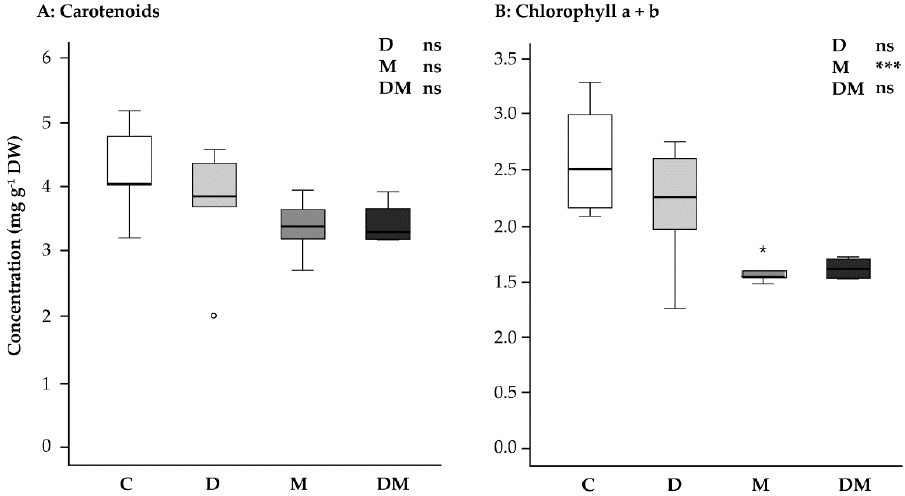
Figure 2. Effect of application of drought (D) and MeJA (M), separately and combined (D + M), on ( A ) carotenoids ( β -carotene, lutein, violaxanthin, neoxanthin) and ( B ) chlorophyll a + chlorophyll b in Picea glauca needles at second sampling point. Results of a two-way ANOVA are shown at upper right. ns , not significant; ***, p < 0.001; white circles indicate outliers and asterisks indicate extreme values; C, control.